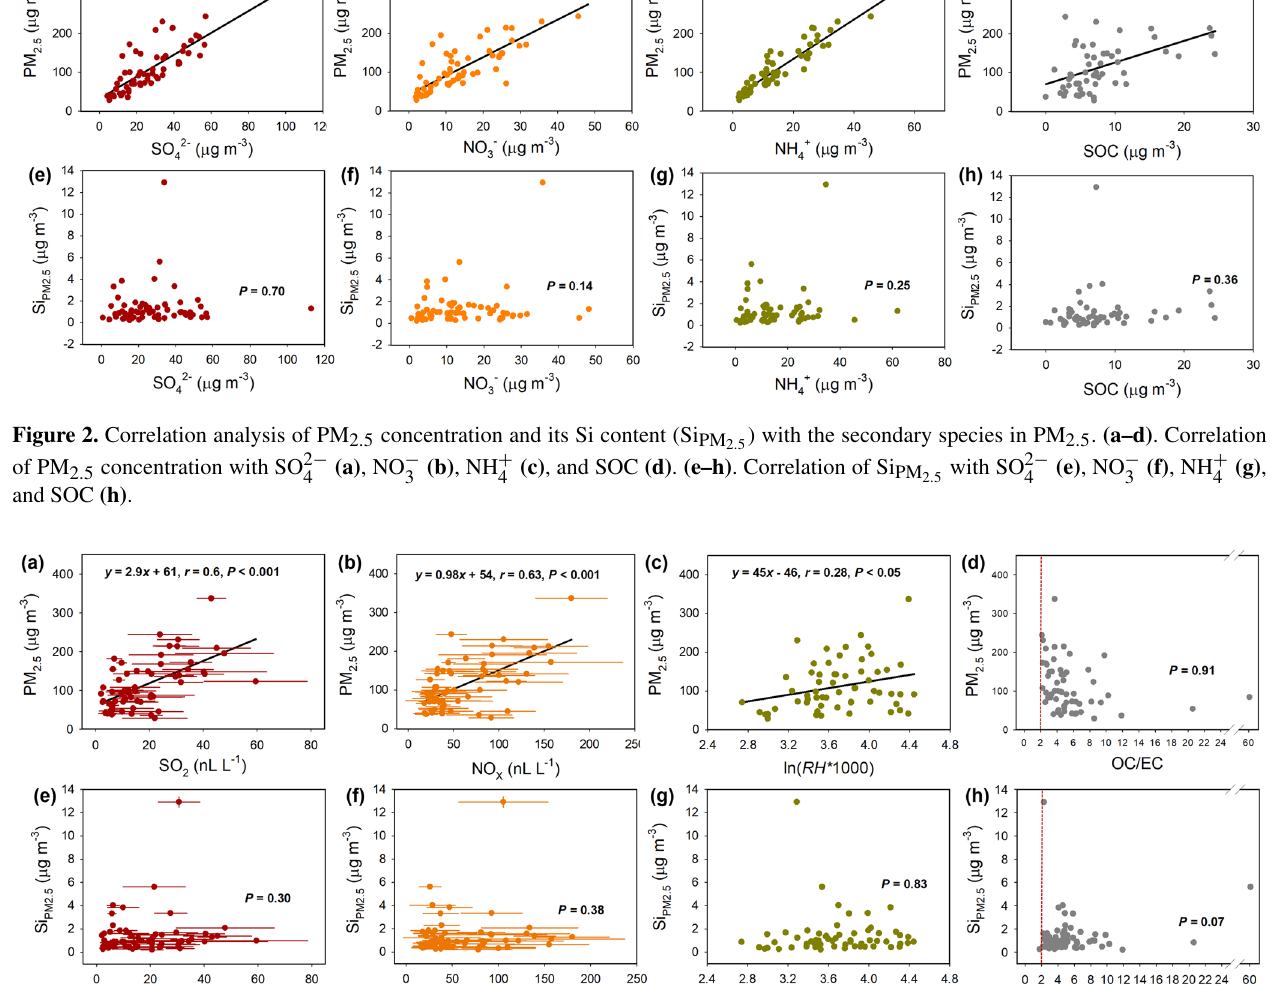
with typical secondary aerosol precursors and relative humidity (RH). 2 . 5 with SO 2 2 . 5